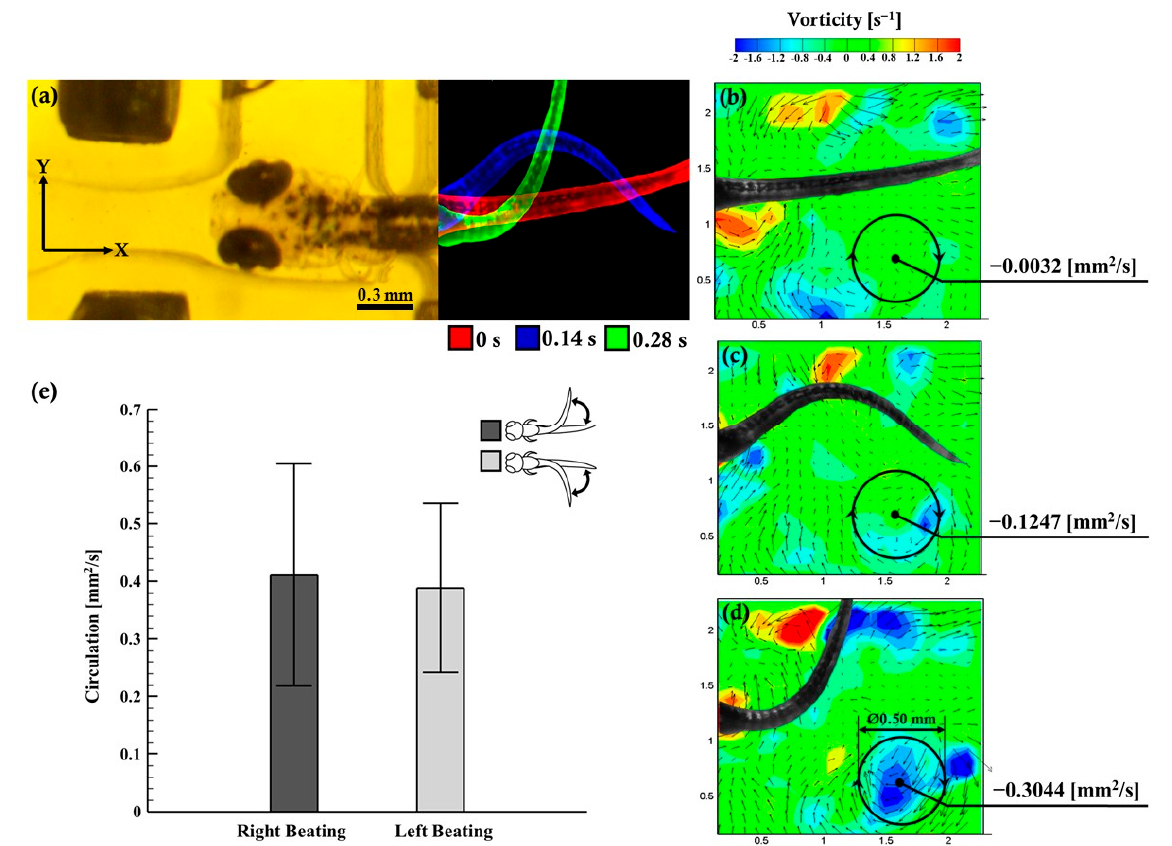
Figure 3. ( a ) The microphotograph of the zebrafish (6 d.p.f.) fixed in the observation region for tail quantification time. ( b – d ) The hydrodynamic quantificational measures of the zebrafish tail beating. The vorticity field (color map) is overlapped with the velocity vector field (black arrows) generated during tail beatings of zebrafish larvae (6 d.p.f.). ( e ) Instantaneous circulation formation due to the hydrodynamic right and left tail beating of zebrafish larvae (4, 5, and 6 d.p.f.) with effective test samples in each experimental group (N = 10).